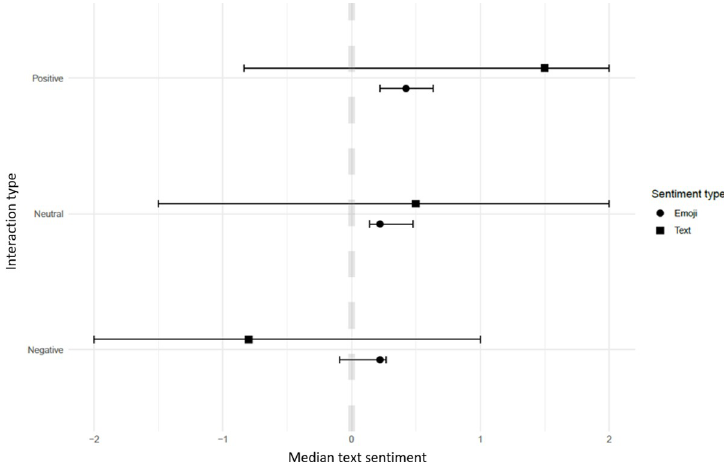
Fig 4. Median text and emoji sentiment of 346 exotic wild cats and primates YouTube 1 videos published between 2006 and 2019 based on interaction between wild cats or primates with other species. Error bars represent first to third